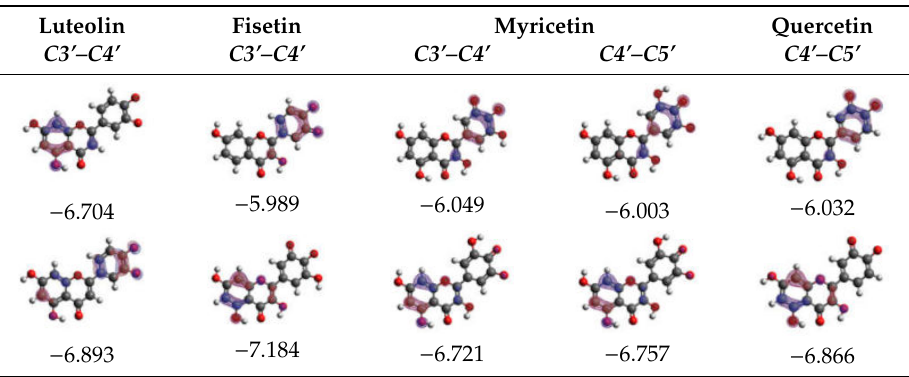
Table A3. Energies of SOMOs of investigated flavonoids’ diradicals